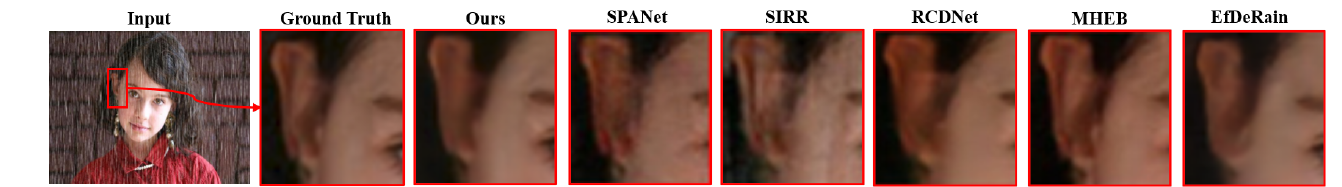
Figure 6. The visualization results on Rain1400. From the details and complexions of the faces and ears, our model(DAMNet) has satisfactory performance while best restraining adverse effects, such as skin tone change and ear deformation.